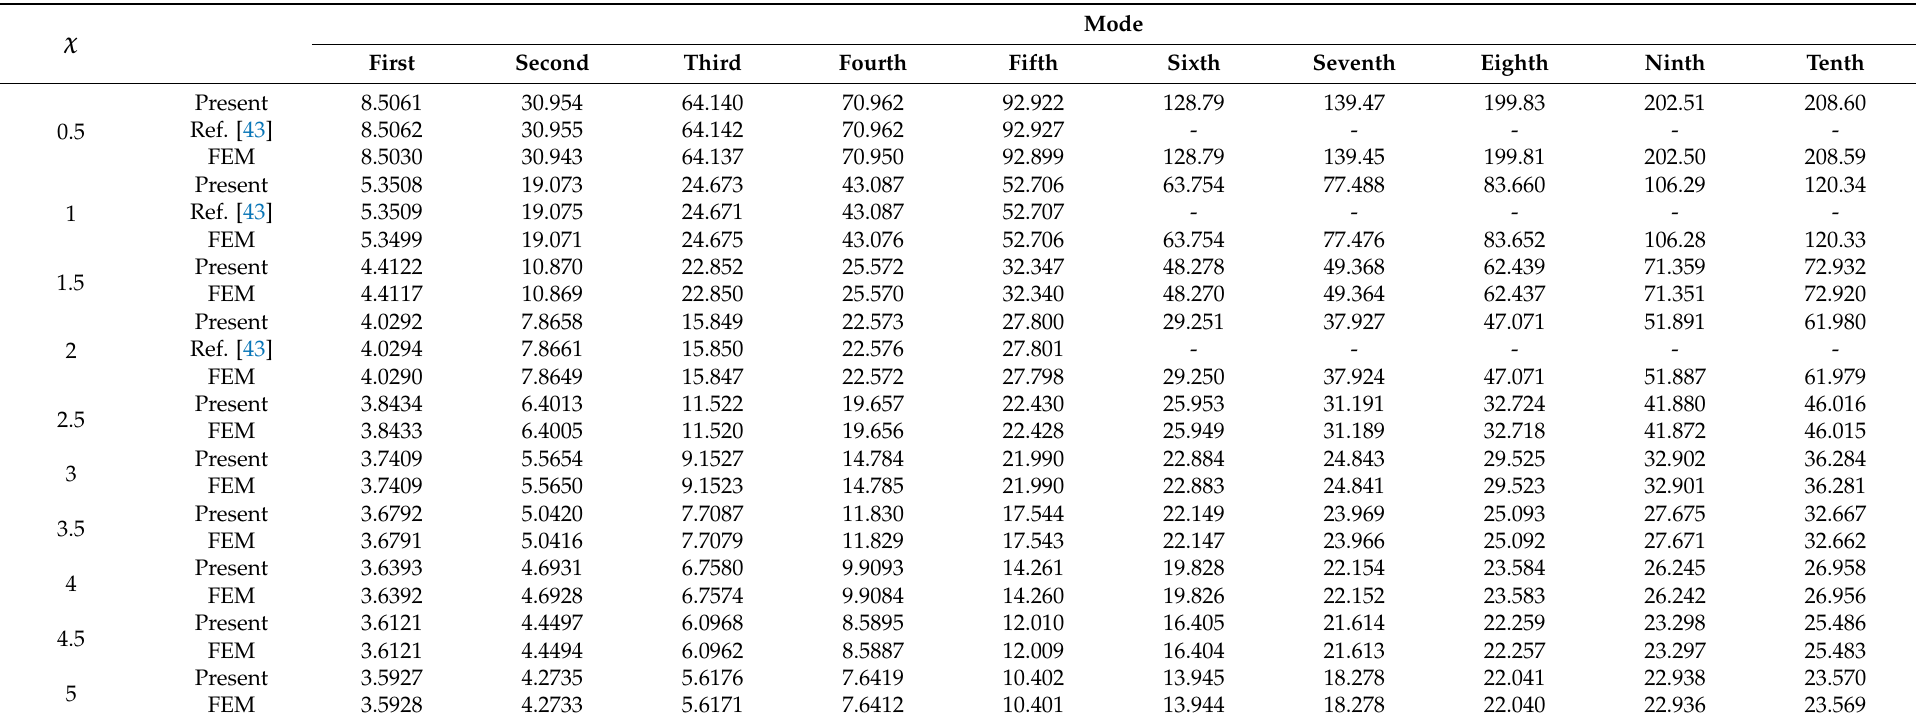
Table 3. Frequency parameter φ of CSFF rectangular plates with defined rotational fixity factors r x 0 = 0.999999, r y 0 = 0.000001 and aspect ratio χ changing from 0.5 to